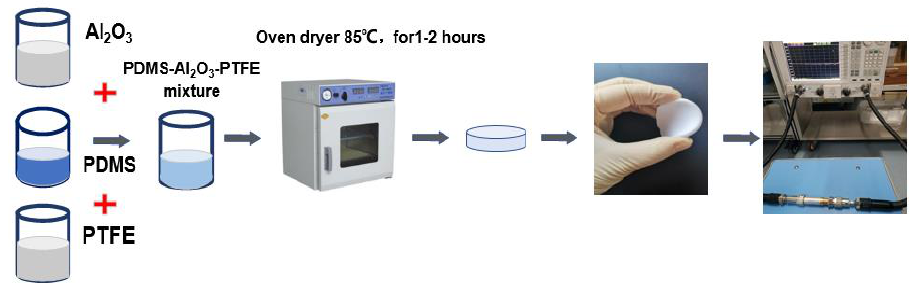
Figure 1. Manufacturing process flow chart.